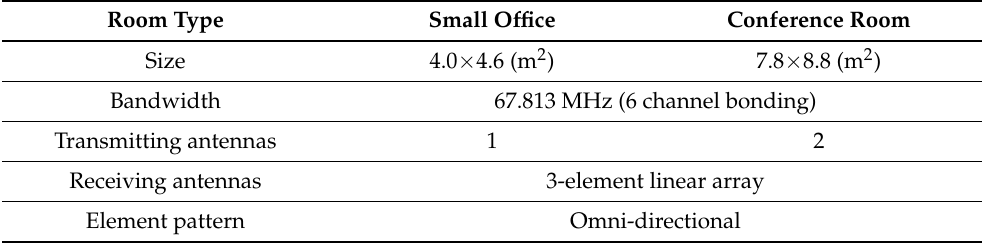
Table 2. Measurement specifications.